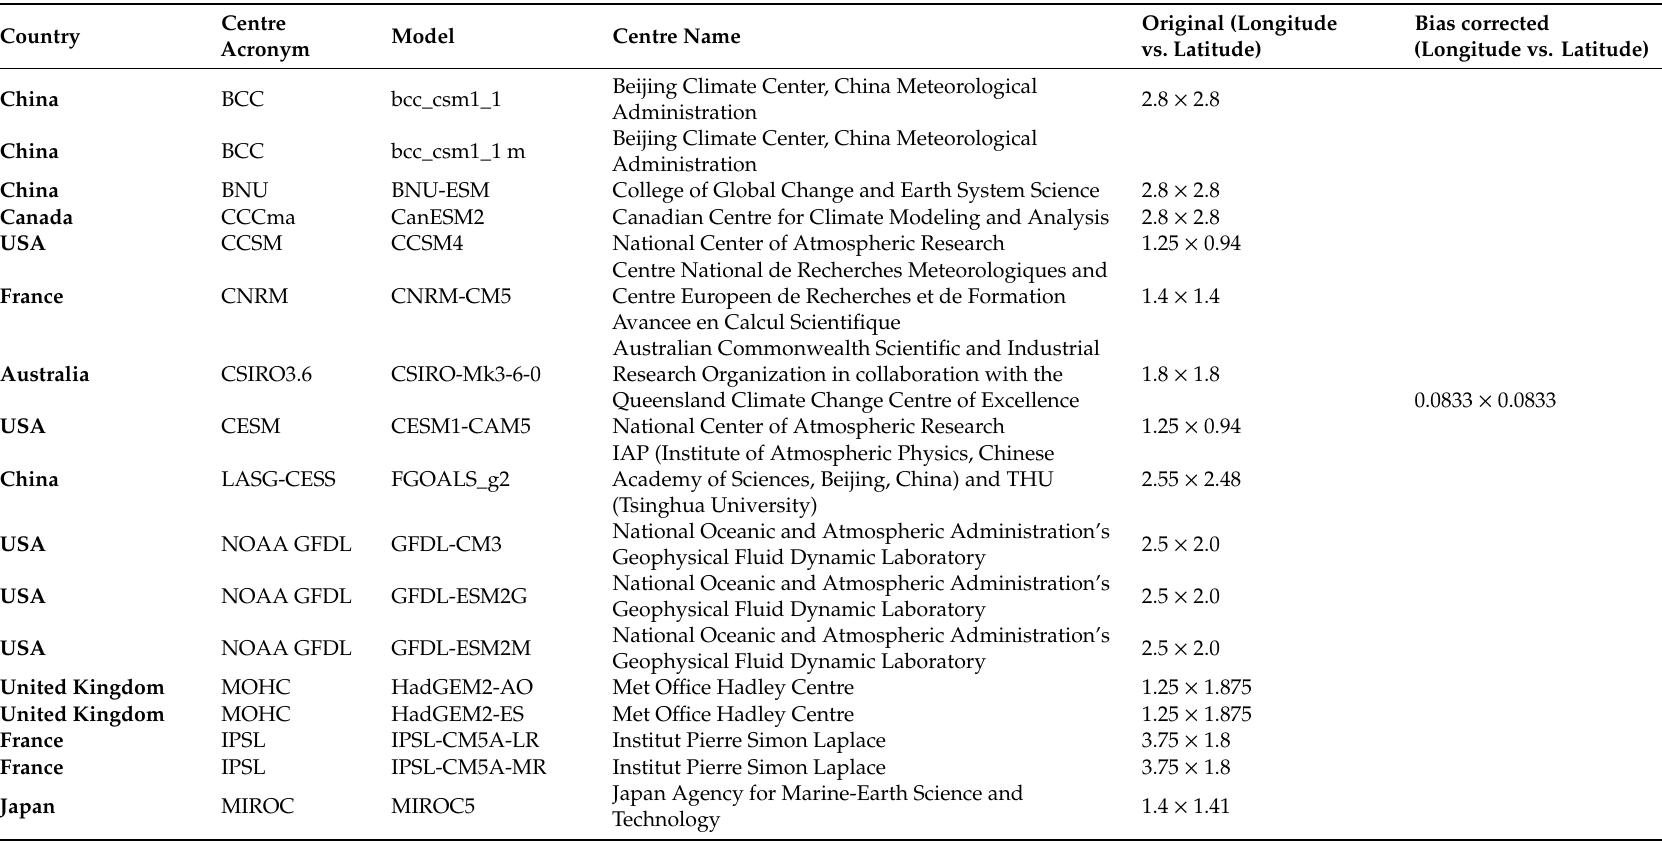
Table A1. The selected bias corrected and downscaled CMIP5 models and their attributes which has all the three emission scenarios (RCP2.6, RCP4.5 and RCP8.5) using the BCCAQ v2